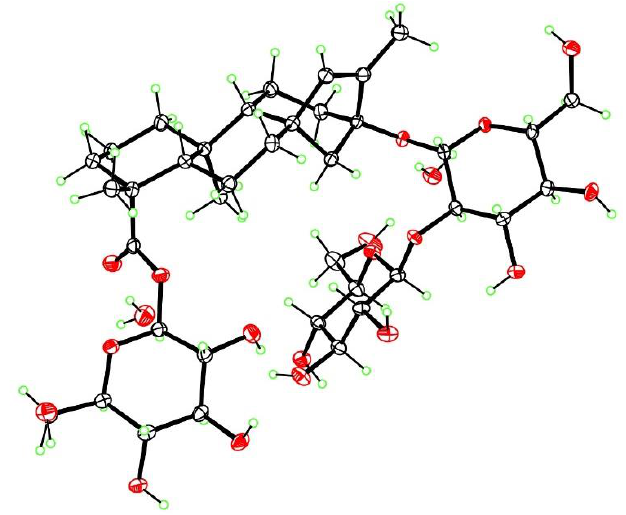
Figure 4. X-ray structure of iso-stevioside dihydrate, with ellipsoids at the 50% level (ORTEP).